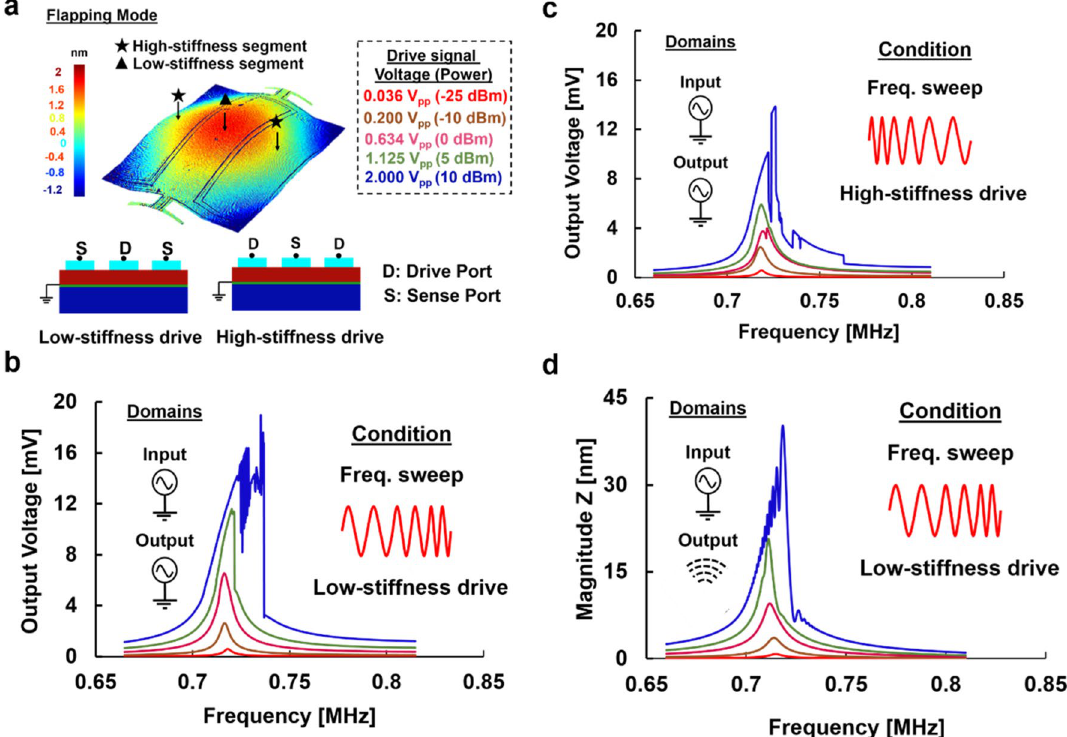
Figure 2. Electrical and mechanical frequency spectra of Device A. ( a ) The mode shape of the resonator with different stiffness regions labeled. Drive/sense configurations employed for nonlinearity measurement of the resonator are also shown. The inset presents the voltage to power equivalency for all measurements in this work. ( b ) Forward frequency sweep for a low-stiffness drive. ( c ) Reverse frequency sweep for a high-stiffness drive. ( d ) Laser Doppler Vibrometer (LDV) out-of-plane motion measurement for forward frequency sweep in the low- stiffness